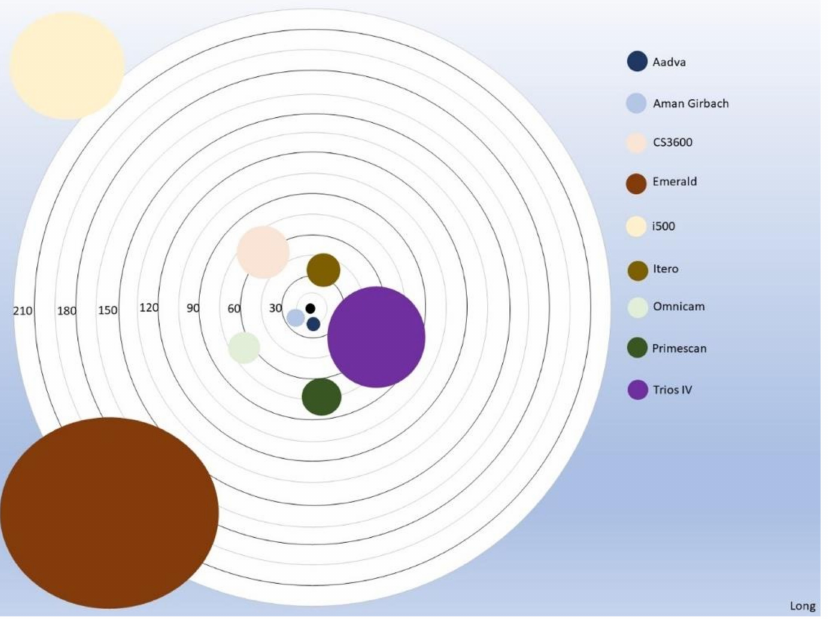
Figure 6. The distance of the circles to the center represents the “trueness” whereas the diameter of the circles represents “precision” for the long